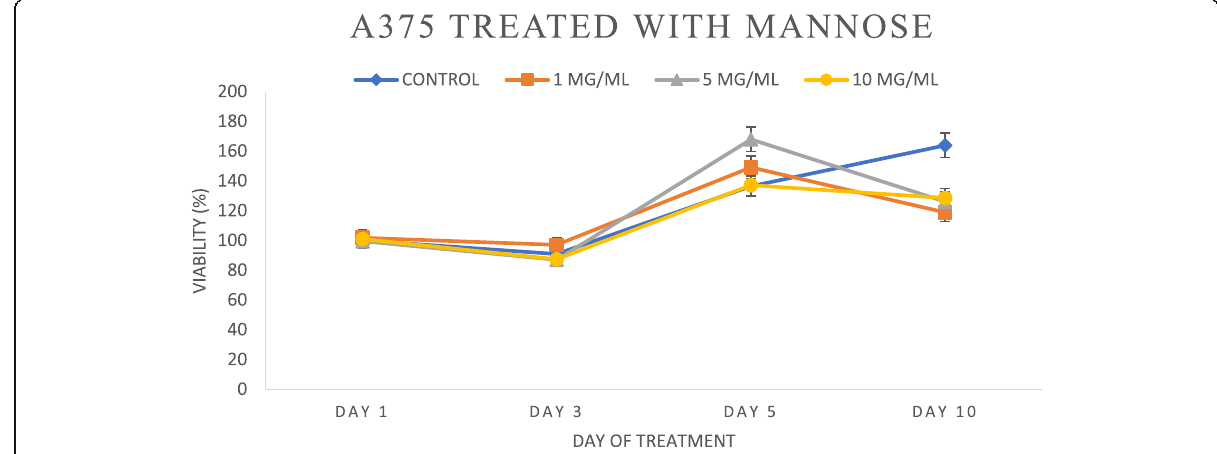
Fig. 2 The percentage of A375 cells when treated with mannose at 1 mg/ml, 5 mg/ml and 10 mg/ml for three period of times; day 1, day 3, day 5 and day 10 ( p value < 0.001)